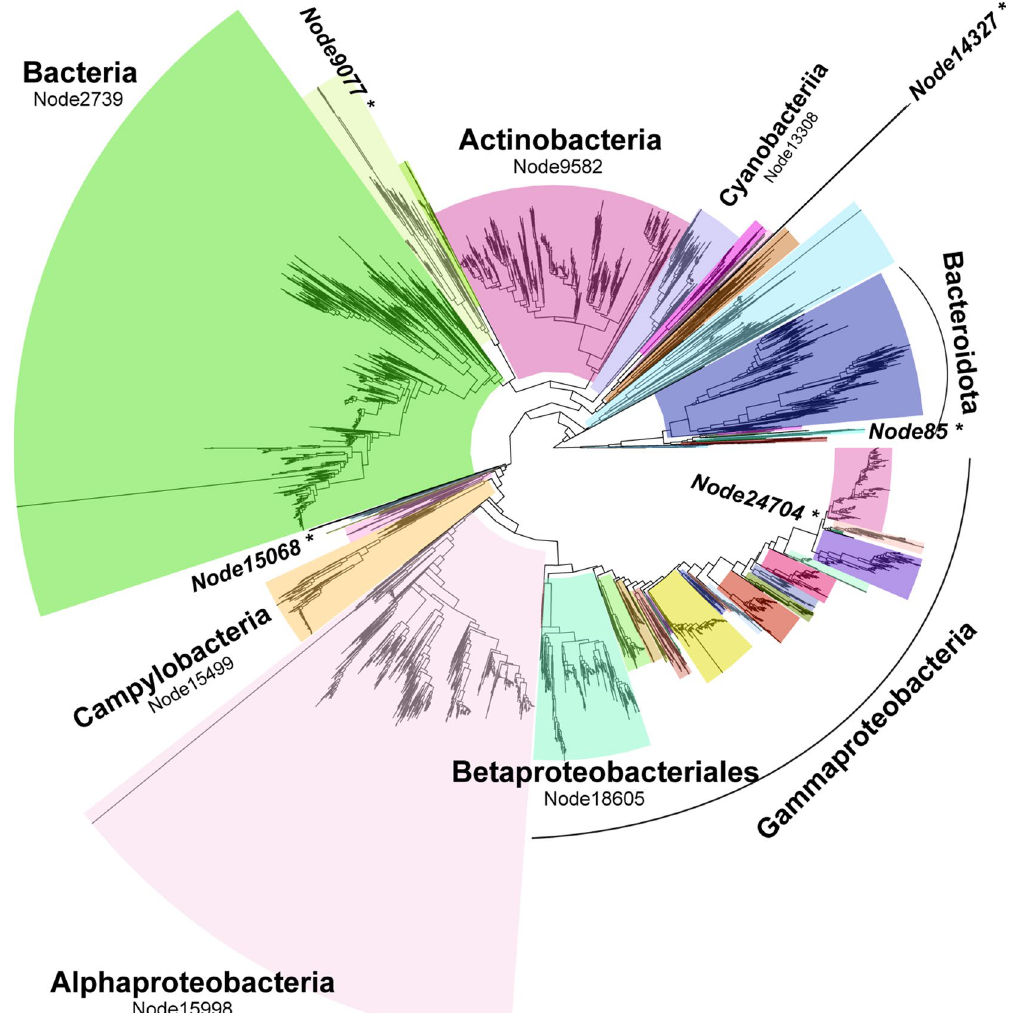
past the functional coherence